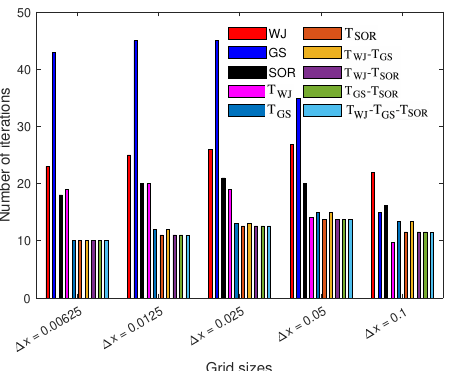
Figure 8. The evolution of the iteration number for the GS, WJ, and SOR methods and the proposed methods in solving the problem (20) with ϑ = 25 and t ∈ ( 0,1 ]